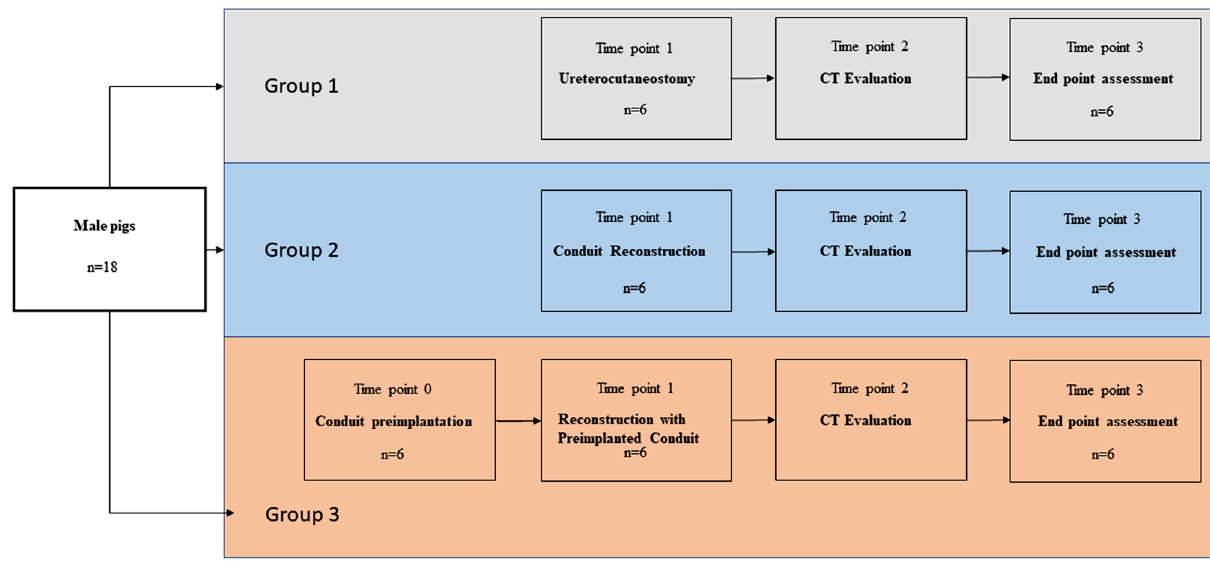
Figure 2. Diagram of the conducted experiment. Timepoint 0—conduit preimplantation 4 weeks before urostomy reconstruction—Group 3, Timepoint 1—urostomy creation, Timepoint 2—(7–8 weeks post urostomy formation), Timepoint 3–6 months post urostomy